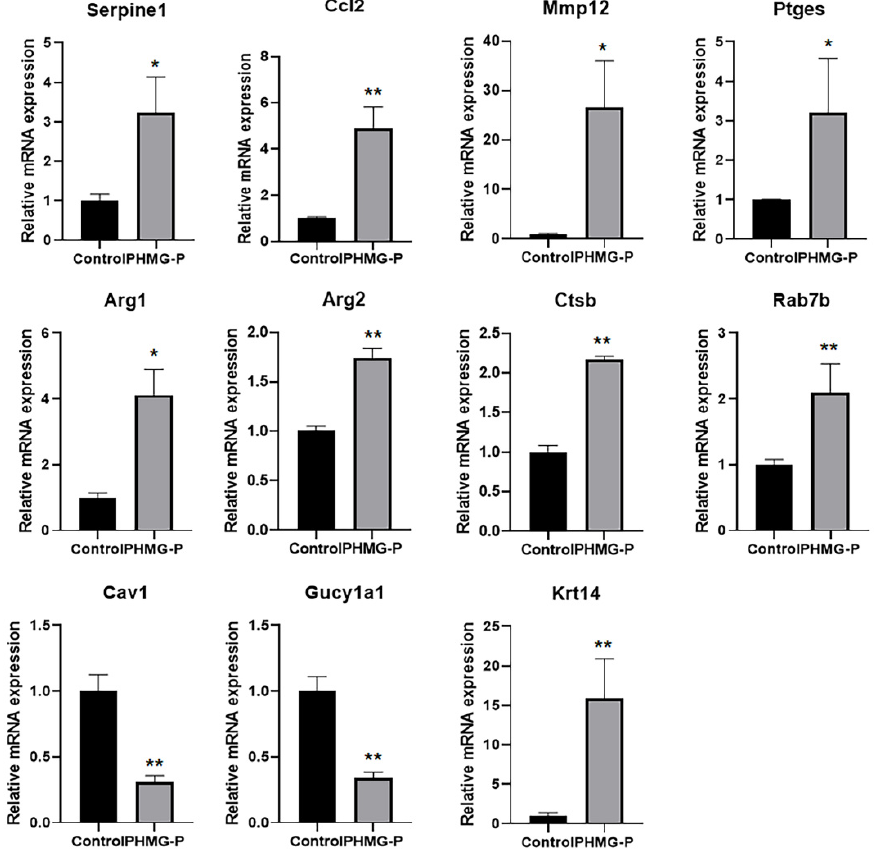
Figure 5. Changes in mRNA expression in the lung tissue of mice following instillation of PHMG-P. Each mRNA was normalized to Hprt and calculated as fold-induction relative to control. The results are expressed as the mean ± SD ( n = 3–4). The values were significantly different from the control group, * p < 0.05 and ** p < 0.01.